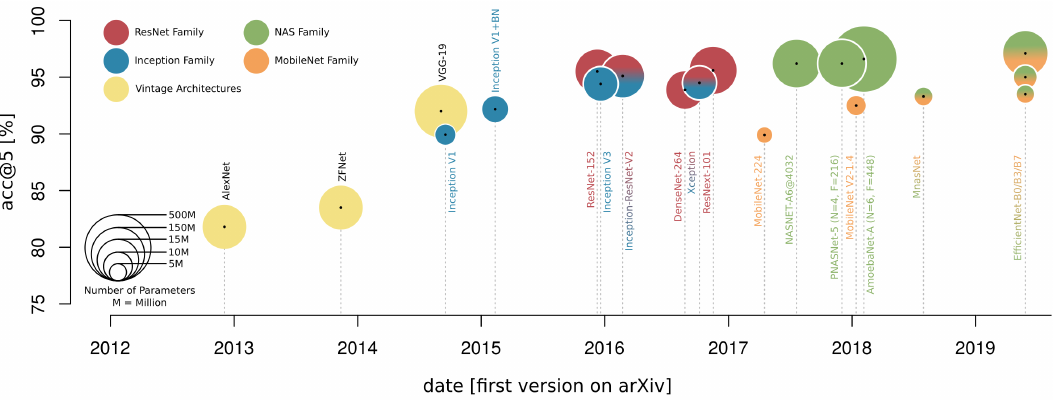
Figure 4. Evolution of milestone architectures for image recognition from 2012 to 2019, compared by their accuracy ( acc @5) metric on the ImageNet 2012 dataset and showing their numbers of parameters in log scale as size of the circle. The different colours show relations between the architectures; mixed colours mean that concepts of two architecture families are combined in those architectures.